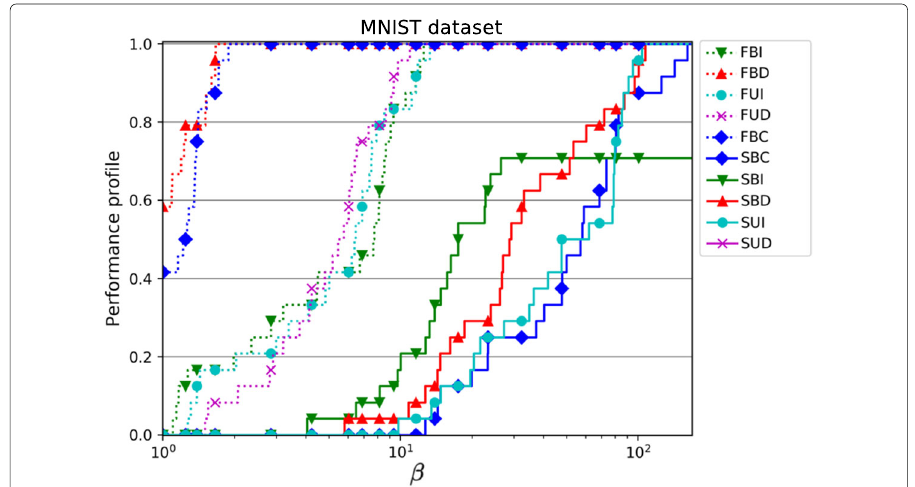
Fig. 13 Performance profile for all 10 methods, for the tests performed on the MNIST data set